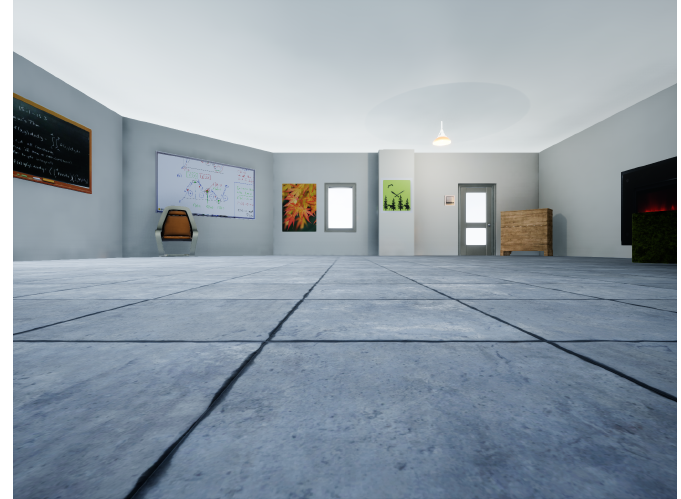
Figure 17. Simulation indoor environment.